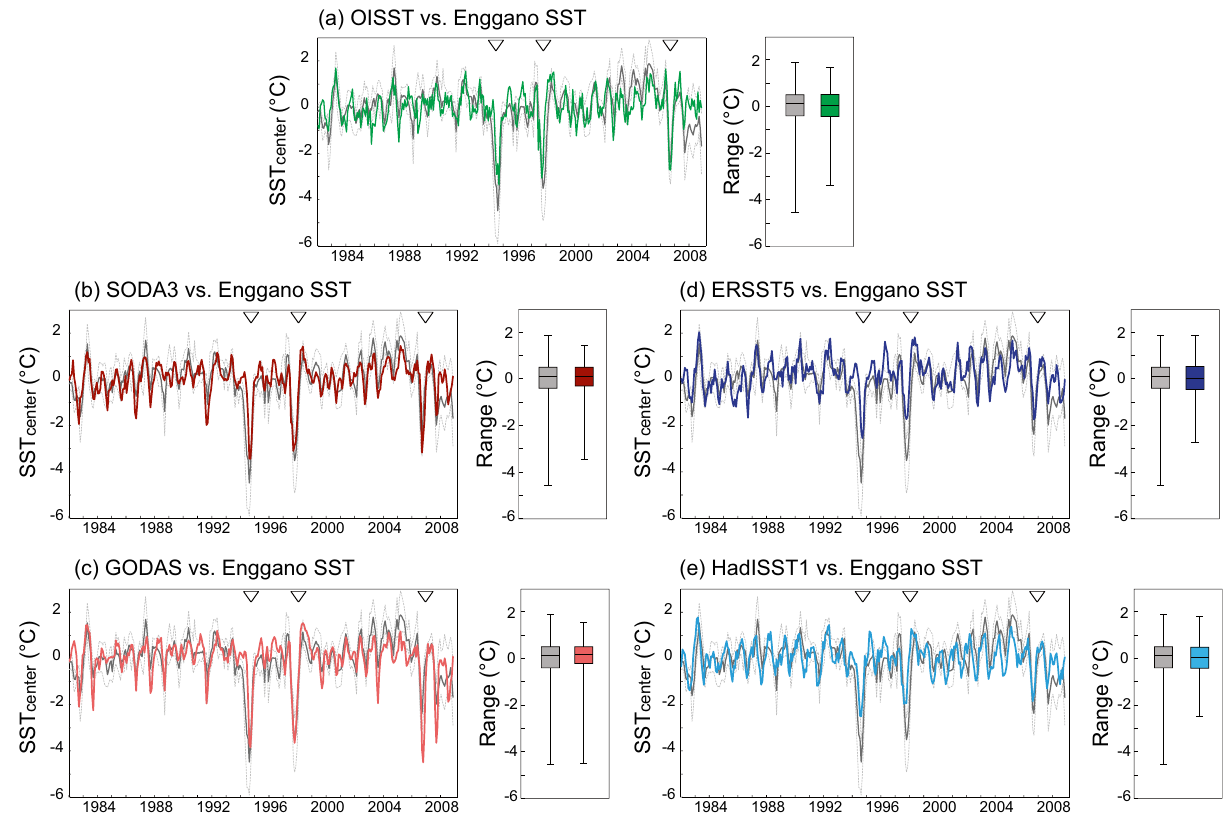
Figure 3. Monthly instrumental SSTs from various products and their SST range (boxplots showing median, interquartile range and maxima/minima as whiskers) compared with the monthly Enggano SST record (in grey) for the time period of 1982–2008. ( a ) OISST (green), ( b ) SODA3 SST (dark red), ( c ) GODAS SST (light red), ( d ) ERSST5 (dark blue), ( e ) HadISST1 (light blue). Arrows mark extreme pIOD events of 2006, 1997 and 1994 discussed in 11 . All time series have been centred to their